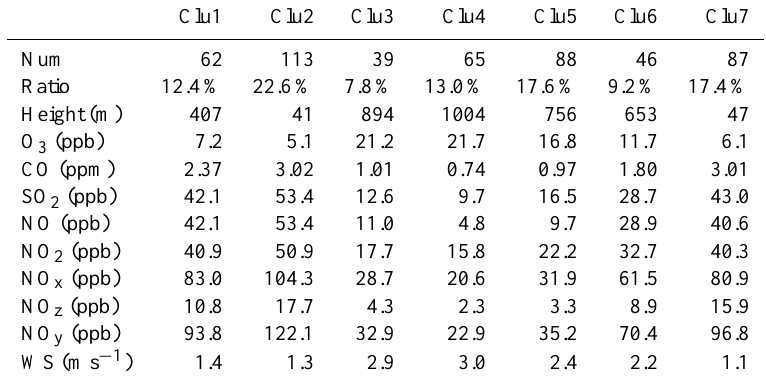
Table 4. Trajectory clusters and their corresponding mean pollutants concentrations, travelling height, and surface wind speed.